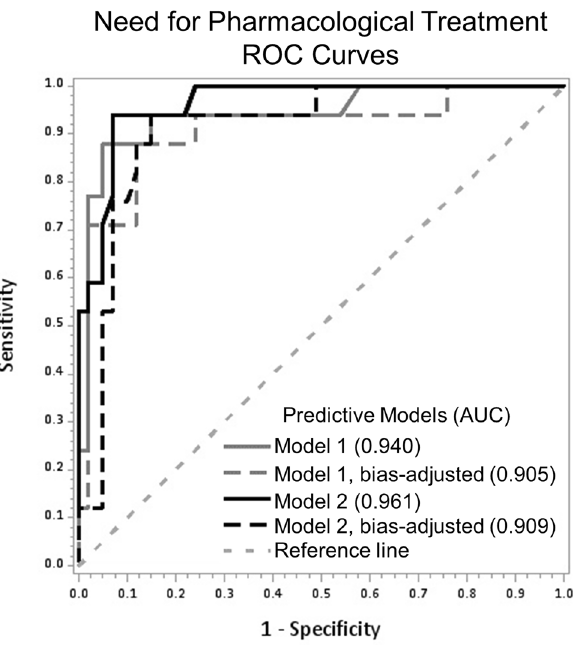
Figure 2. Receiver Operator Characteristic (ROC) Curves for Five miRNAs Differentiating Pharmacologically - Treated and Not-Pharmacologically-Treated Infants. ROC curves for performance of Model 1, containing miR- let-7d-5p, miR-128-3p, miR-30c-5p, miR-421, and miR-584-5p and Model 2, containing the same miRNAs and gestational age. AUC area under the ROC